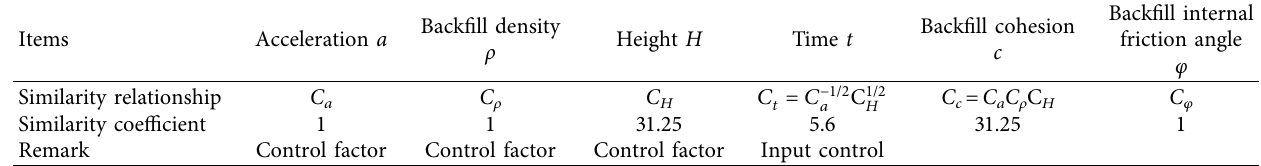
Table 1: Similarity relationship of the main physical quantities of the retaining wall model.